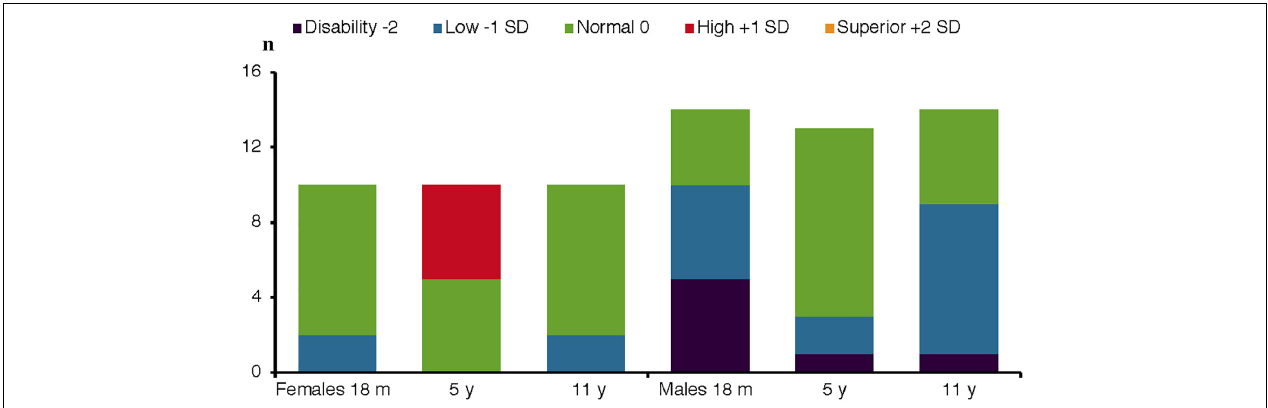
FIGURE 1 | Cognitive level for females and males at three assessment points. Cognitive index scores standardized in levels. Index score < 70 = disability/severe delay. 71–85 = low/moderate delay. 86–115 = normal/average. 116–130 = high. < 131 = superior. Assessment at 18 months, 5 and 11 years of age, 10 female and 14 male preterm VLBW